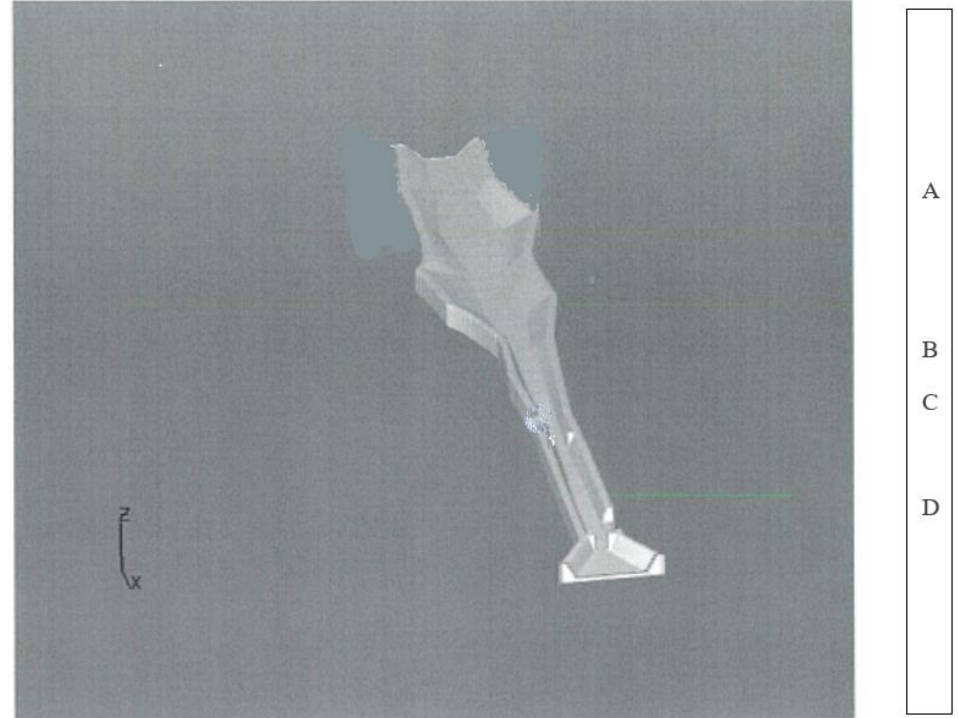
Figure 10. Northern embankment canal geometry ahead of the steep descent canal to the lower aqueduct. FLOW-3D model [1], p.118 modified by author.